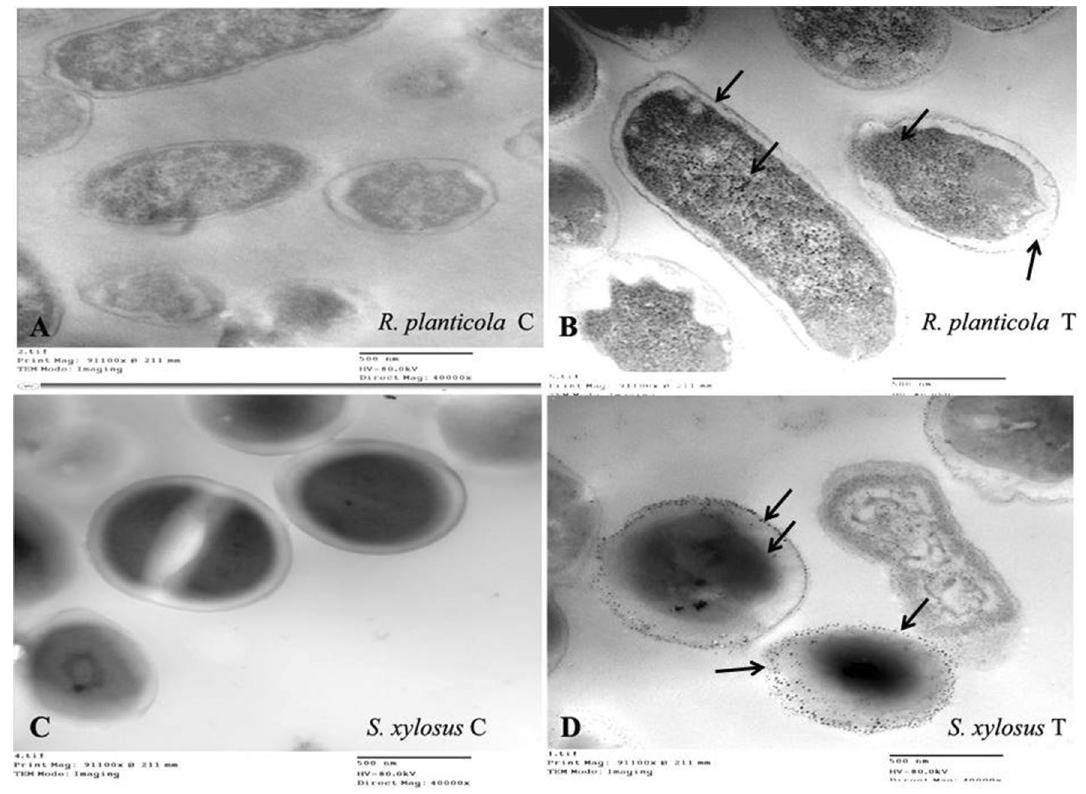
Fig. 3 Transmission electron micrograph with magnification (40000 supplemented with 2000 ppm Pb and without as control. A and B represent R. planticola while C and D represent S. xylosus. Arrows indicate to the metal accumulation